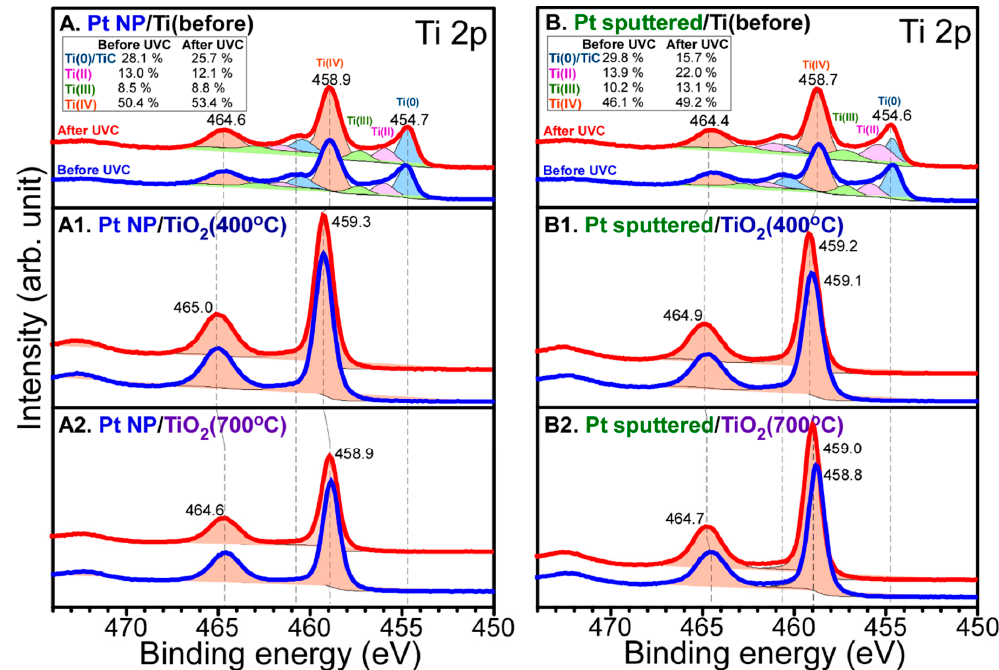
Figure 4. Ti 2p XPS of: ( A ) Pt NP / Ti; ( A1 ) Pt NP / Ti (400 ◦ C); ( A2 ) Pt NP / Ti (700 ◦ C); ( B ) Pt-sp / Ti; ( B1 ) Pt-sp / Ti (400 ◦ C); ( B2 ) Pt-sp / Ti (700 ◦ C) samples before (blue) and after (red) CO 2 reduction. Inset tables show relative ratios of the deconvoluted peaks.